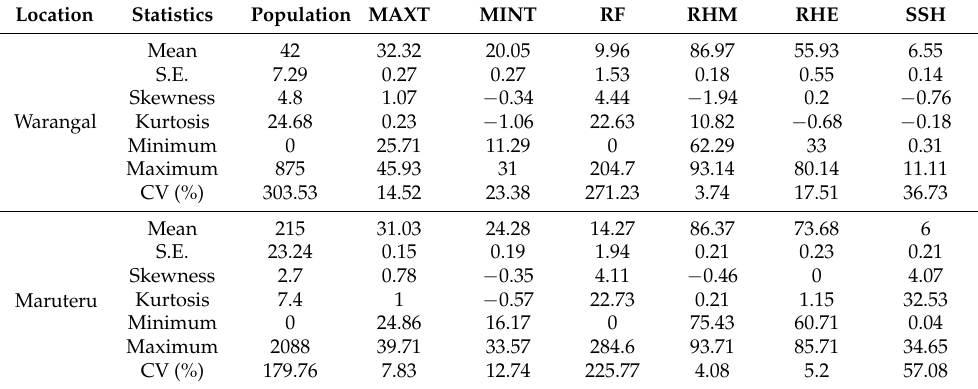
Table 1. Summary statistics of gall midge light trapped individual collections at study